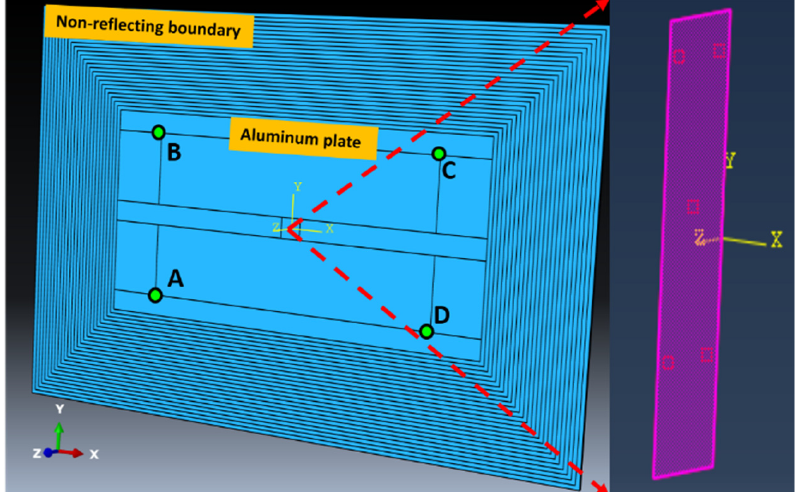
Figure 9. Schematic diagram of the aluminum plate with a breathing crack in FE